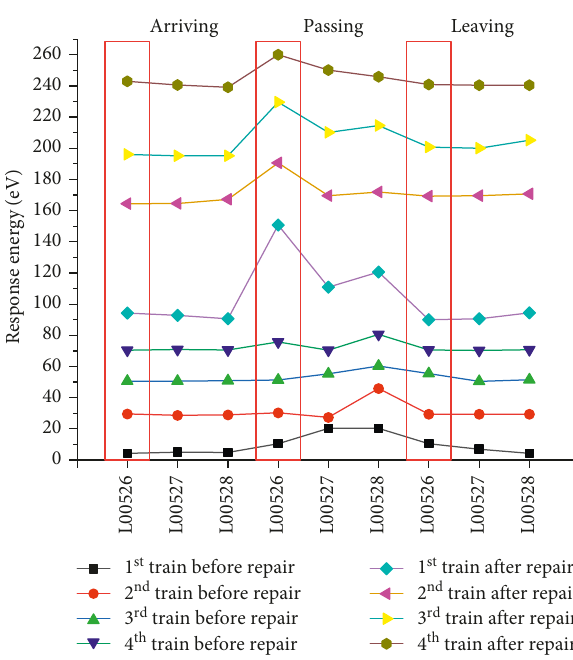
Figure 19: Response energy of the left